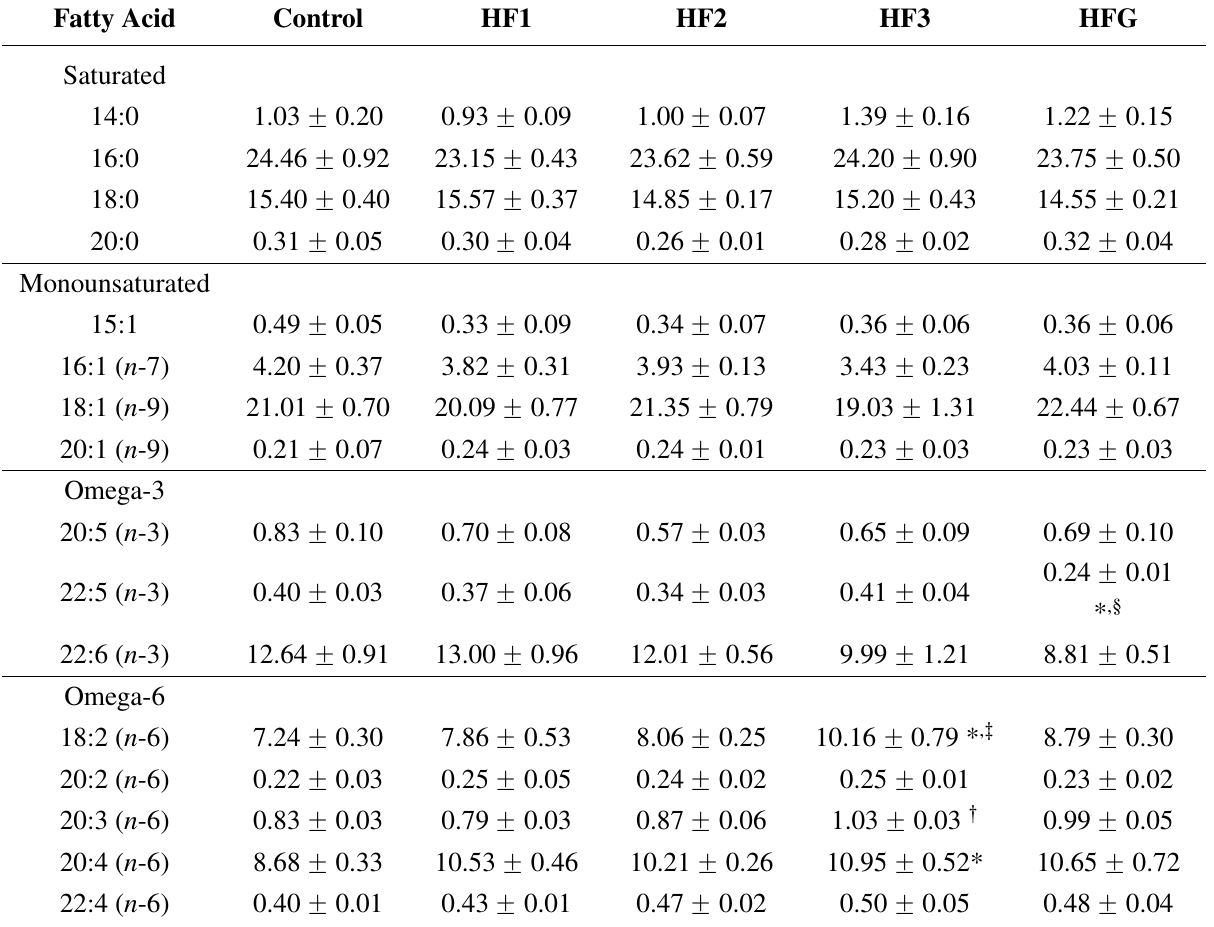
Table 3. Hepatic fatty acid profiles (%) of 20-day-old rat fetuses exposed to a maternal high fat